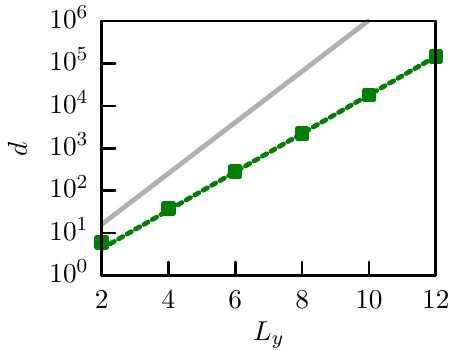
, in absence y (grey line), the y obtained from log-linear regression y